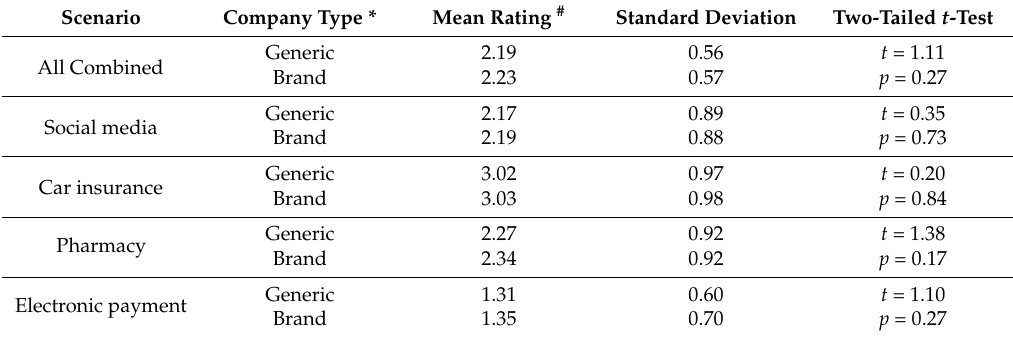
Table 4. Descriptive statistics (two-tailed t -tests comparing responses across generic and brand